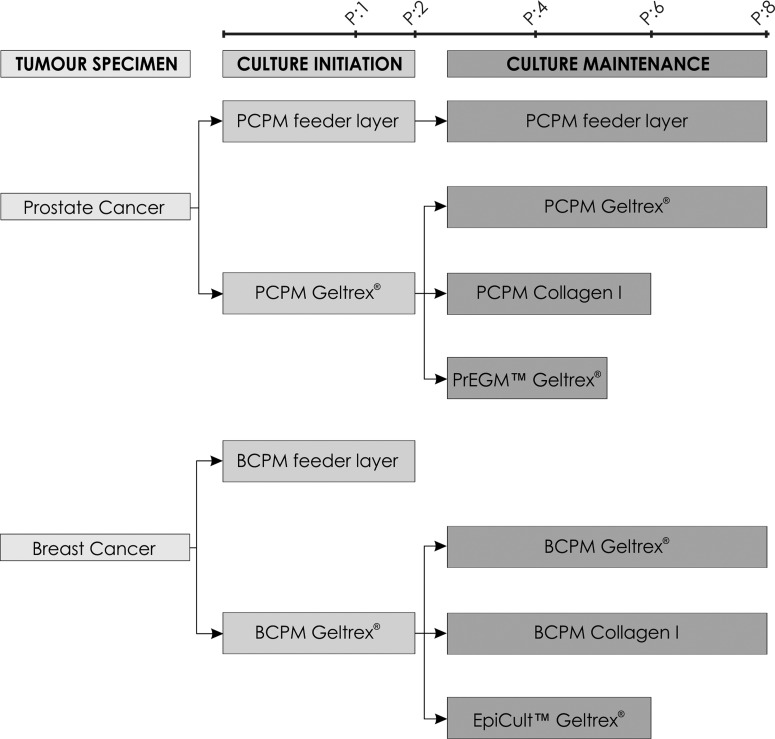
Schematic experiment workflow–various attempts to culture primary epithelial breast and prostate cancer cells.